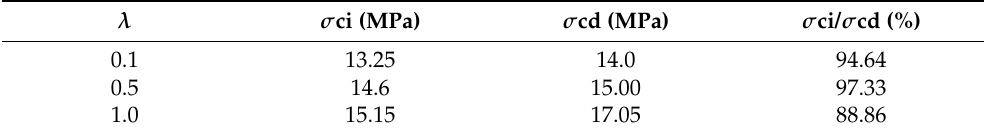
Figure 11. Cumulative crack length and AE counts of fracturing hole change with calculation time step under different λ when ξ = 1.0. Table 2. Crack initiation stress, fracture stress and their ratio under different λ .